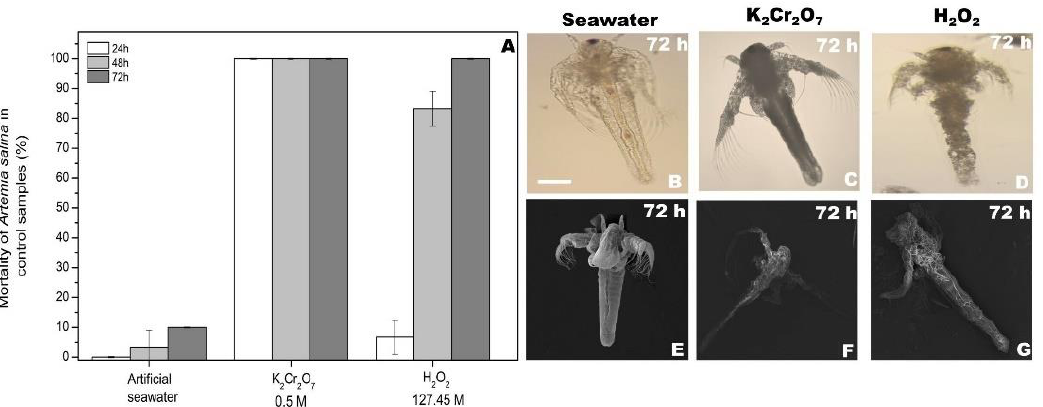
Figure 3. Control samples during protective effect in the 24/48/72 h interval against H 2 O 2 in Artemia salina nauplii ( A ). Morphological changes in the Artemia salina nauplii after 72 h of exposure under optical microscopy seawater ( B ), K 2 Cr 2 O 7 ( C ), and H 2 O 2 ( D ). Morphological changes in the Artemia salina nauplii by scanning electron microscopy seawater ( E ), K 2 Cr 2 O 7 ( F ), and H 2 O 2 ( G ). Bars, 200 µm.